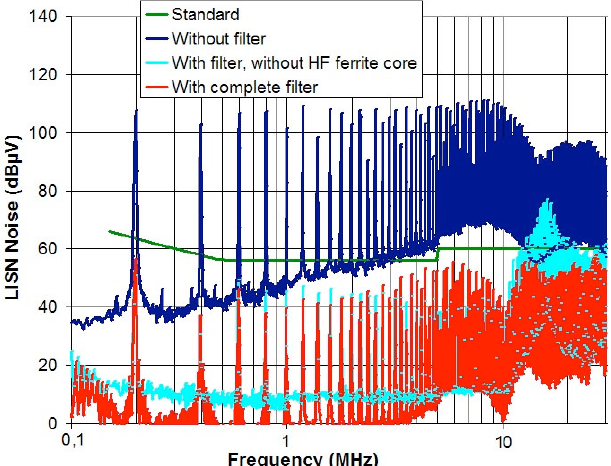
Figure 33: Comparison of conducted emissions in three configuration